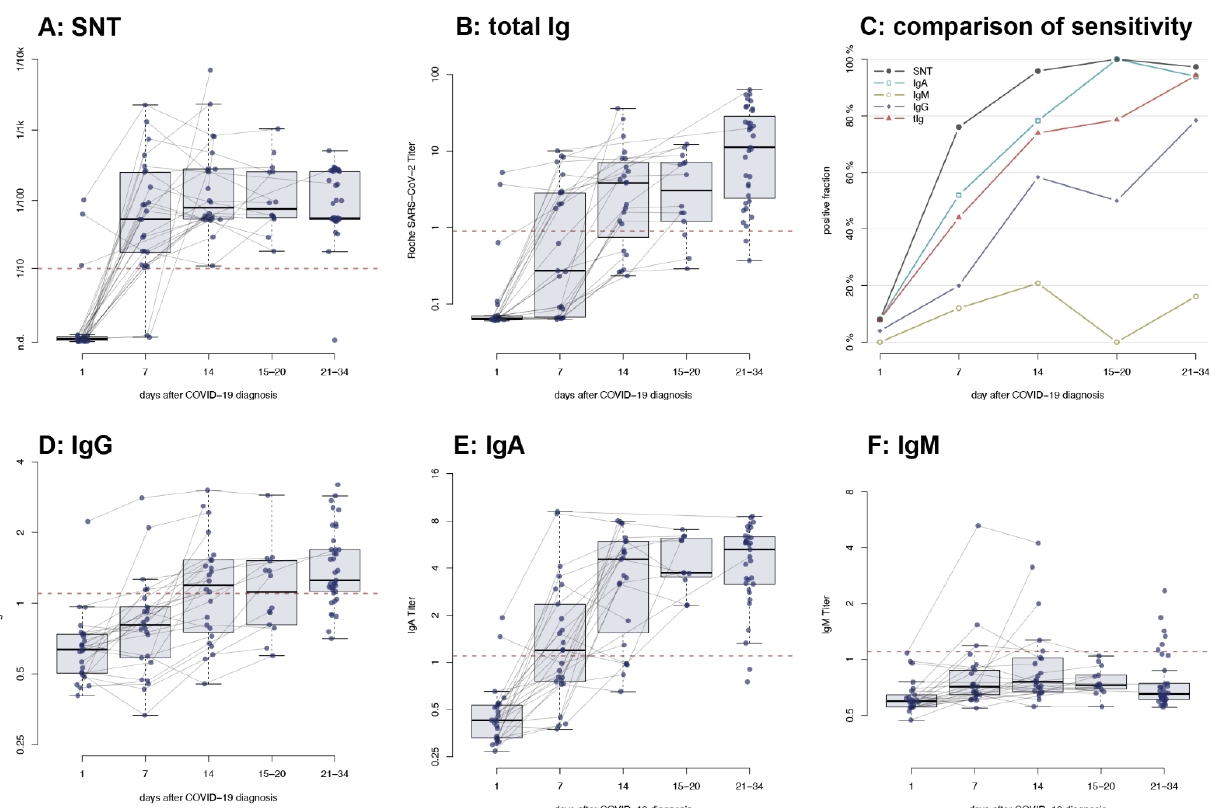
Figure 3. Time course of antibody titers of patients with non-severe COVID-19 measured on d1, d7, d14 and d30 post diagnosis: ( A ) neutralizing antibodies measured by serum neutralization test (SNT); ( B ) total SARS-CoV-2-specific anti- bodies measured by electrochemiluminescence immunoassay (ECLIA), ( D ) immunoglobulin (Ig) G, ( E ) IgA, and ( F ) IgM; ( C ) sensitivity of each test at the separate time points post-diagnosis. Dashed line: limit of detection as indicated by the manufacturer ( B , D – F ) or as determined by the experimental setting ( A ). n.d. = not detected.